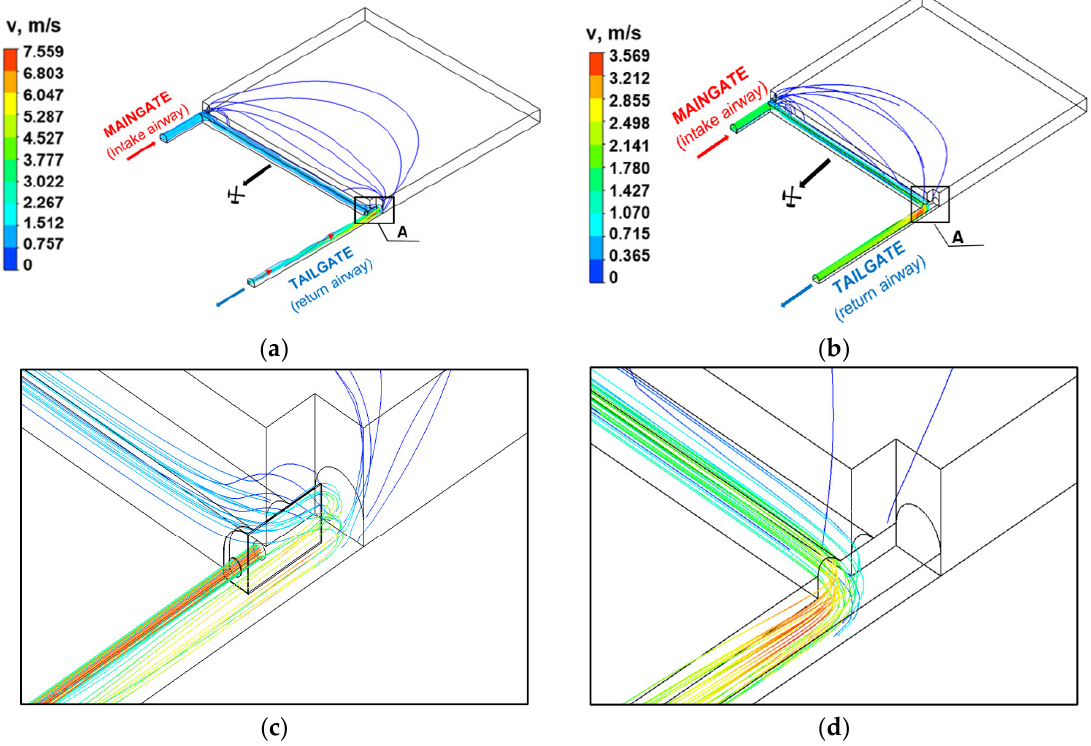
Figure 7. The trajectories of air flowing through the intersection of the longwall and the airway with built-in AVE ( a , c ) and without such equipment ( b , d ).